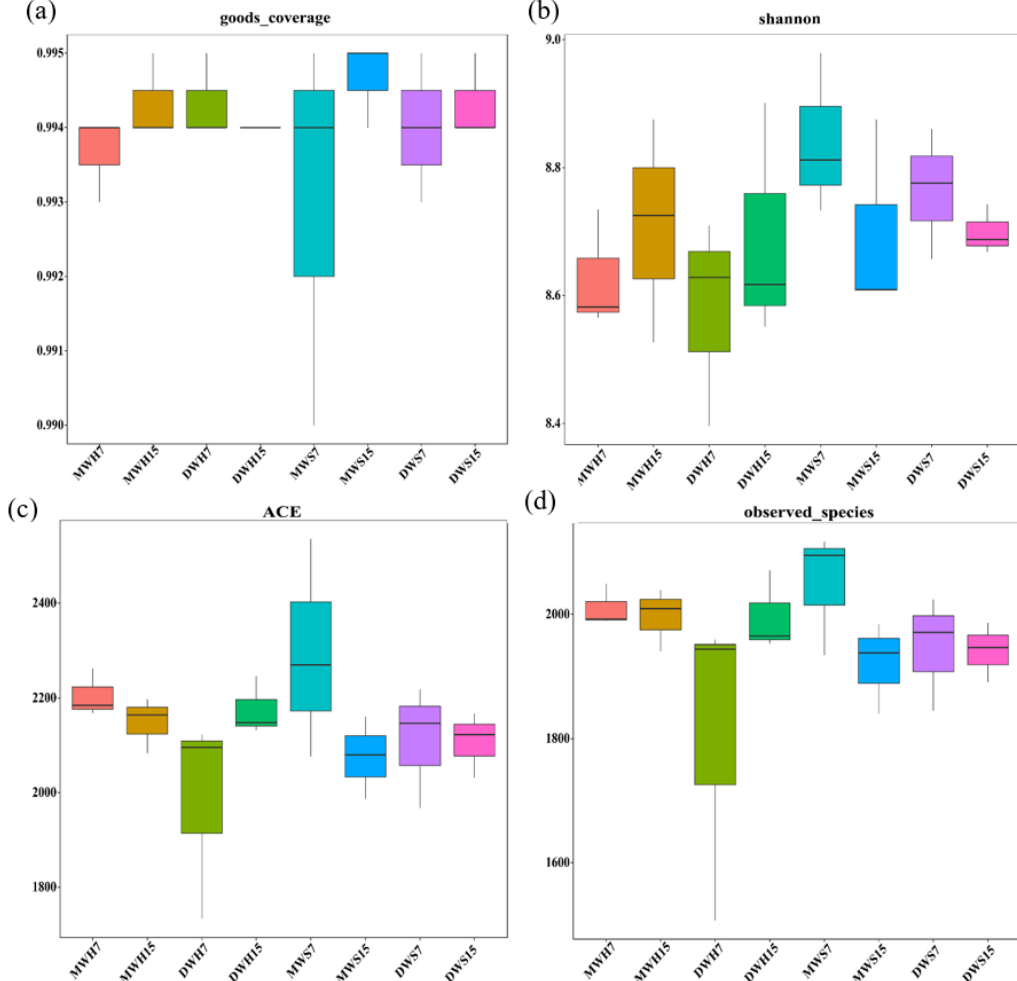
Figure 1. Estimators of the alpha diversity of bacterial community in the samples. ( a ) Good’s coverage; ( b ) Shannon index; ( c ) ACE; ( d ) observed species. MWH7 = wheat harvested at 7:00 in milk stage and